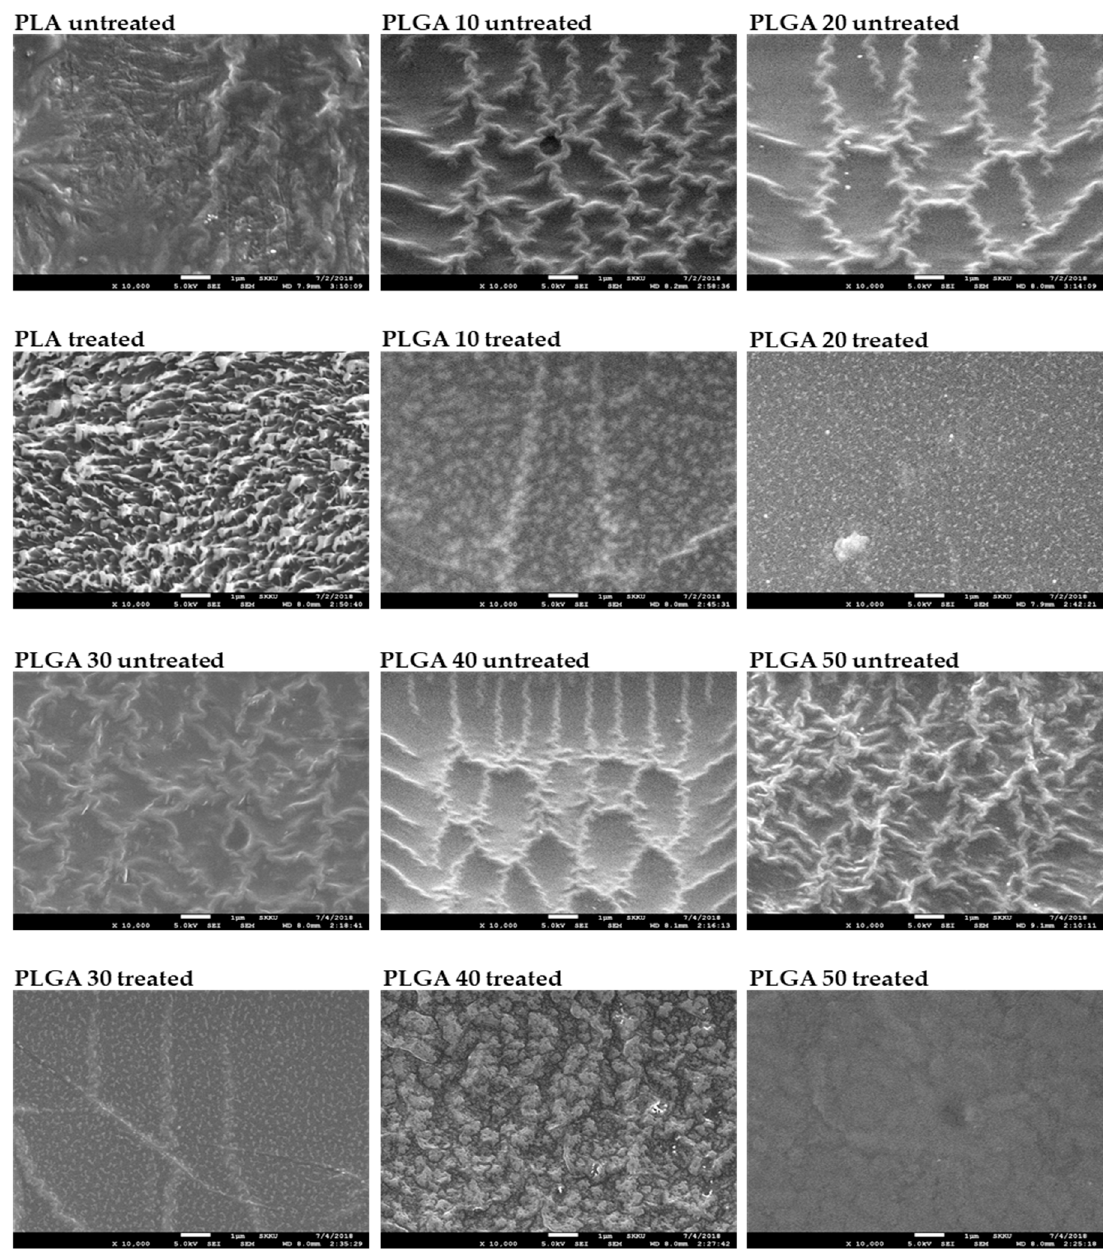
Figure 5. SEM images of polymer films, prior to and after oxygen plasma treatments.